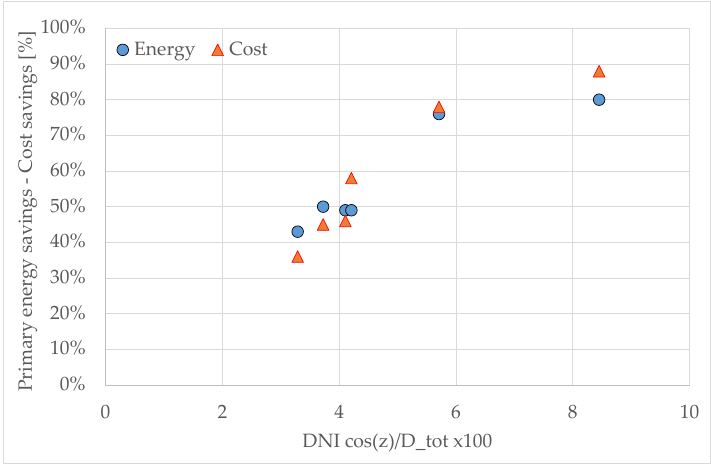
Figure 7. Energy and costs savings of the Innova MicroSolar plant in relation with the solar irradiance and with the building energy demand.